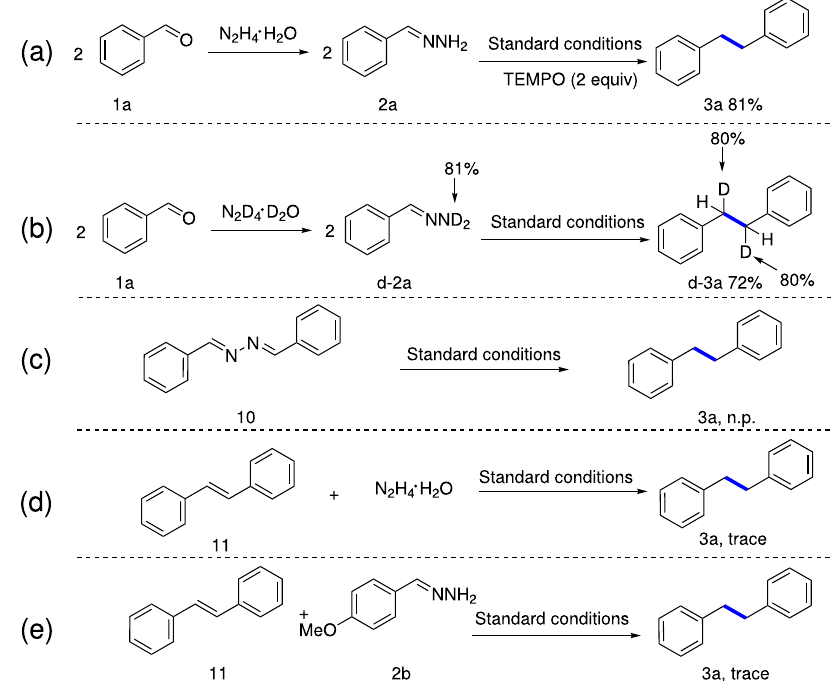
Fig. 4 Mechanistic studies. a Free radical capture experiment. b Deuterium-labeling experiment. c Experiment to verify possible azine intermediate. d Experiment to verify possible intermediate ( E ) − 1,2-diphenylethene reacting with hydrazine. e Experiment to verify possible intermediate ( E ) − 1,2- diphenylethene reacting with hydrazone 2b .